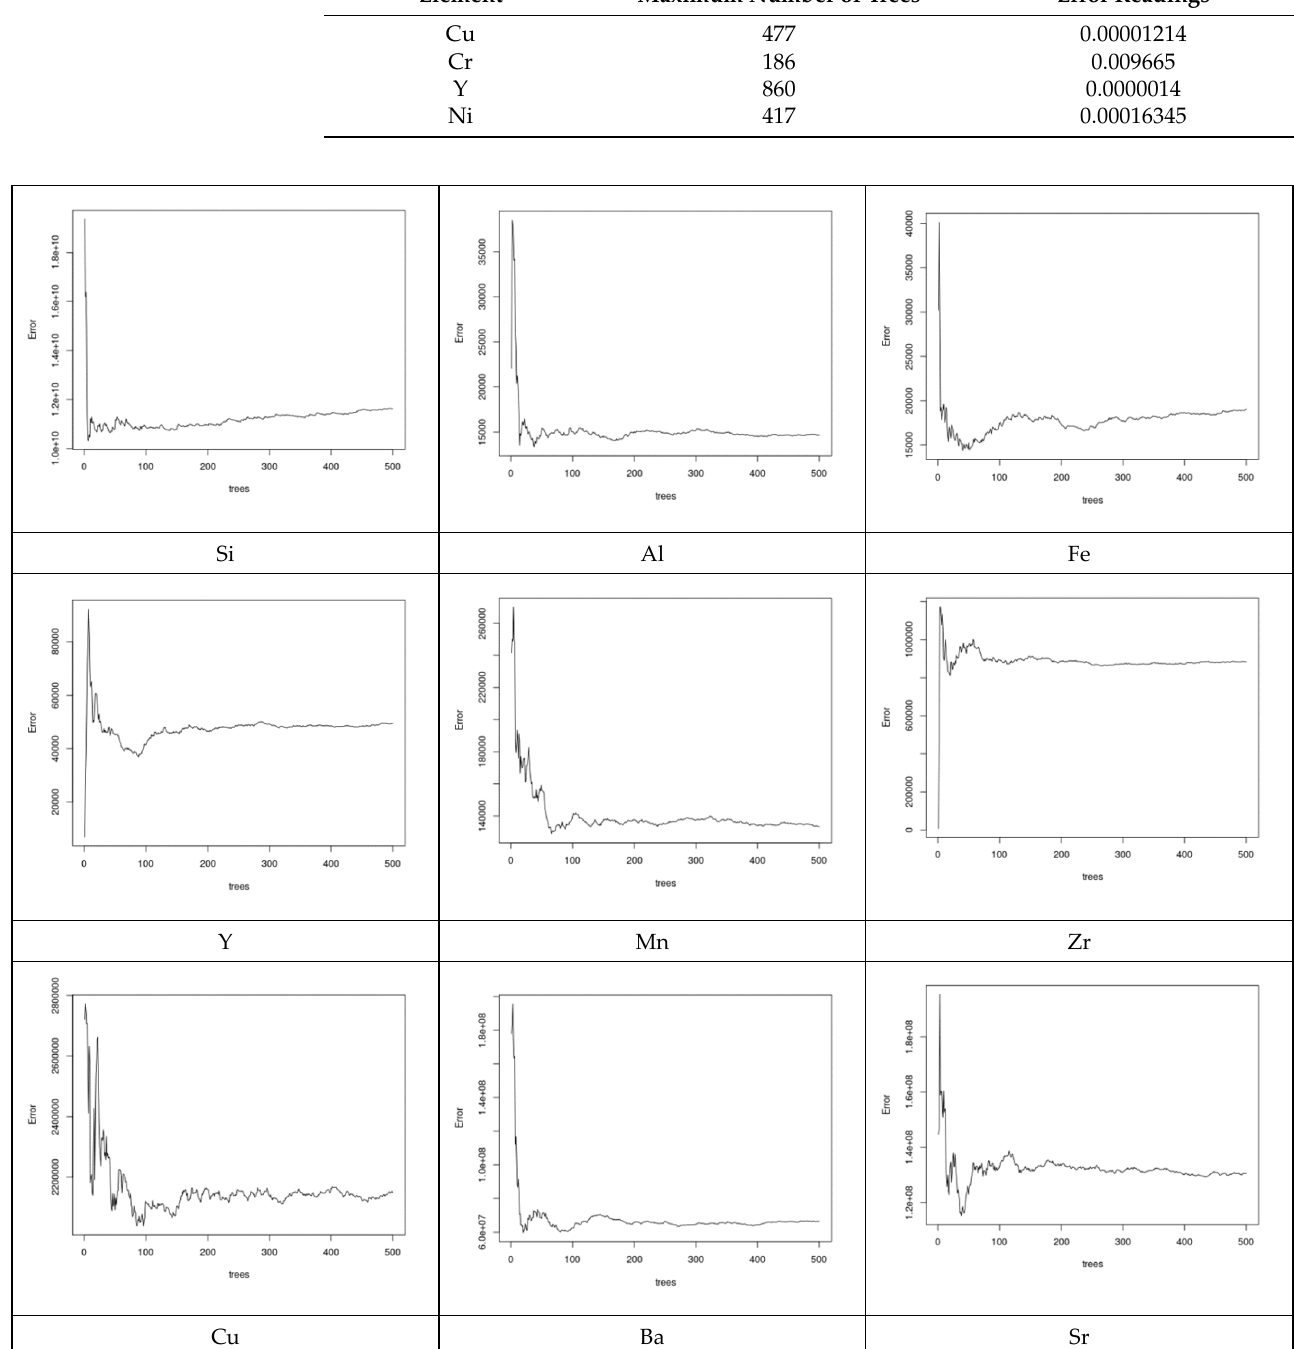
Figure 9. Prediction error of the RF models for some selected elements. Different elements have different error prediction characteristics to determine the best number of trees to use. Table 3. Maximum values of the number of trees and their error readings of RF .